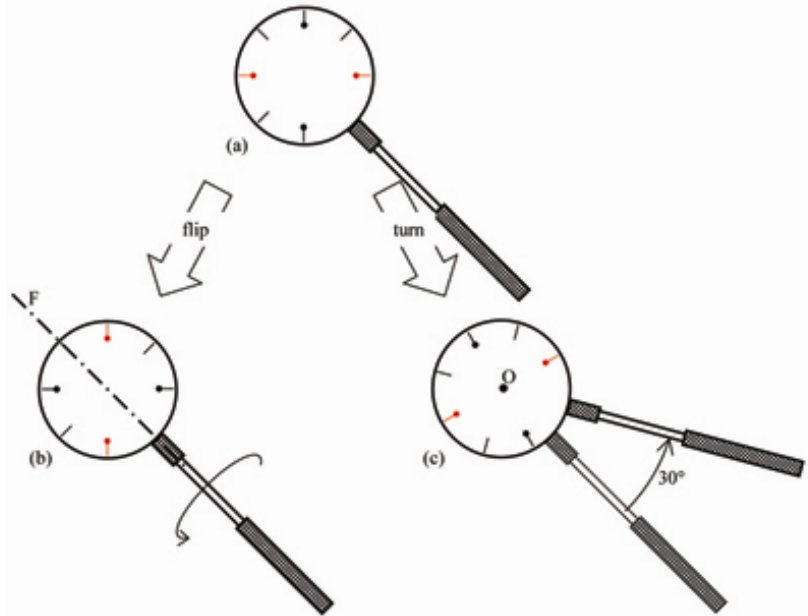
Figure 6 The two operations performed clinically on a Jackson cross-cylinder. (a) A Jackson cross-cylinder oriented as in Figure 1. (b) The Jackson cross-cylinder of (a) has been flipped about the flip axis F; the lens undergoes a rotation of 180 ° . The back surface is brought to the front and vice versa. The red and white pins change places. The projections of the two cylinder axes C + and C ¯ change places. In space the axes are now a little more than 1 m above the plane of the figure. The principal meridians change places. (c) The lens in (a) has been turned through 30 ° about the optical axis O. The powers of the lenses are listed in